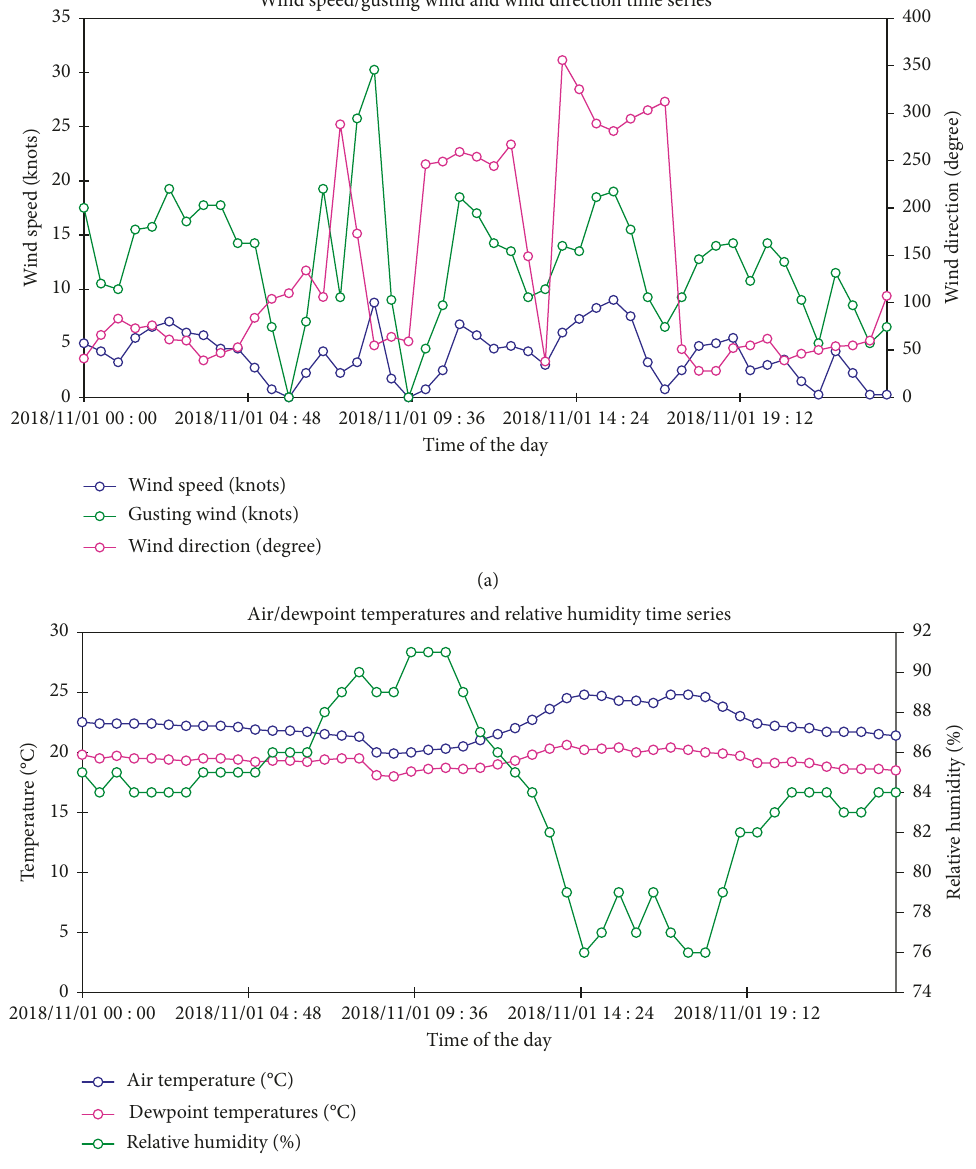
Figure 6: Twenty-four-hour wind speed, gusting wind (both in knots), and wind direction (degree) (a) and relative humidity (%), air temperature ( ° C), and dewpoint temperature ( ° C) (b) for the day of January 11,